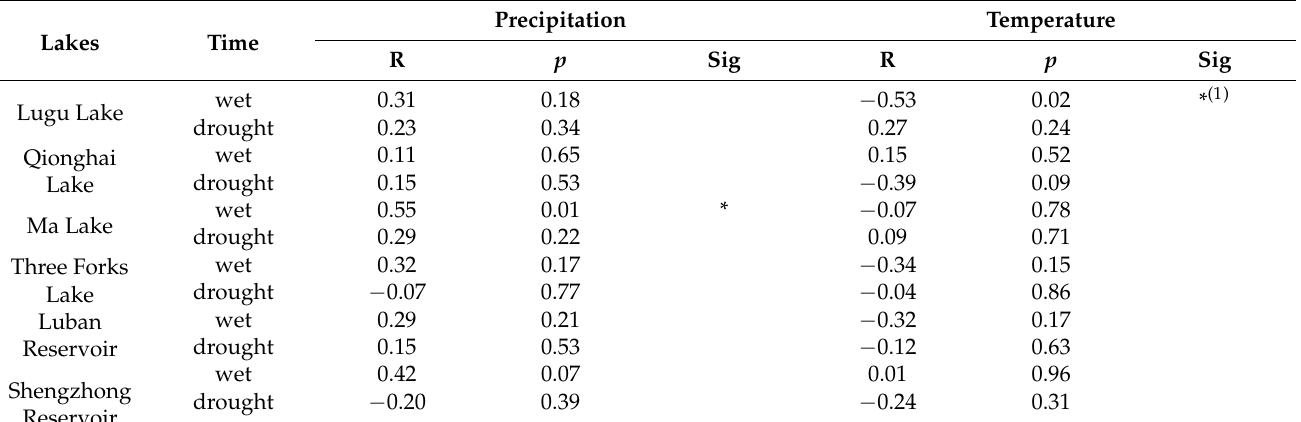
Figure 11. Characteristics of the drought and wet season variation in precipitation (mm). ( a ) Lugu Lake; ( b ) Qionghai Lake; ( c ) Ma Lake; ( d ) Three Forks Lake; ( e ) Luban Reservoir; ( f ) Shengzhong Reservoir. Note, the direction of the dashed line indicates the trend of precipitation in the drought and wet season. Table 8. Correlation of area with precipitation and